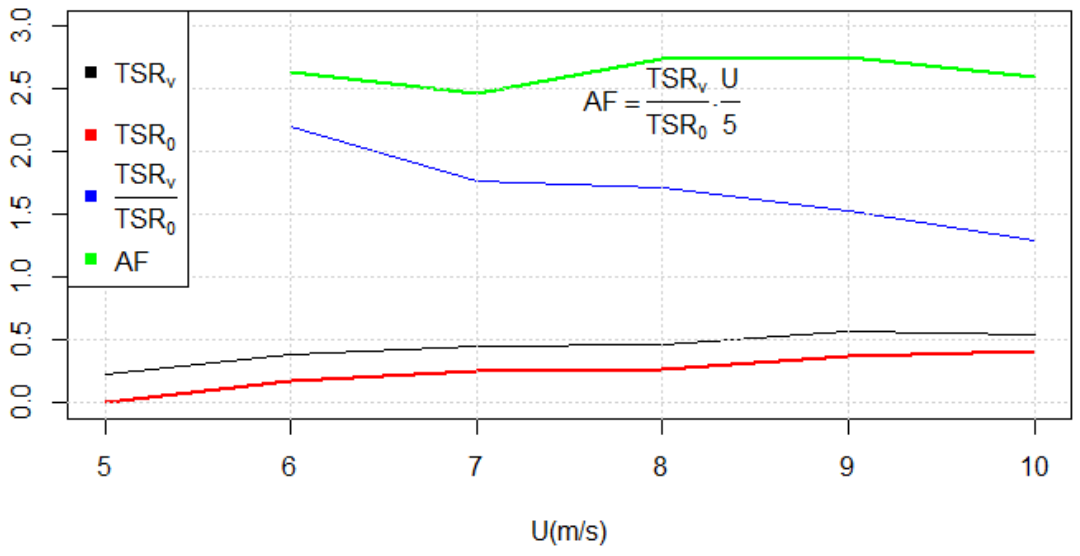
Figure 9. TSRs, the ratio, and the corrected ratio for the rotor speed with and without the